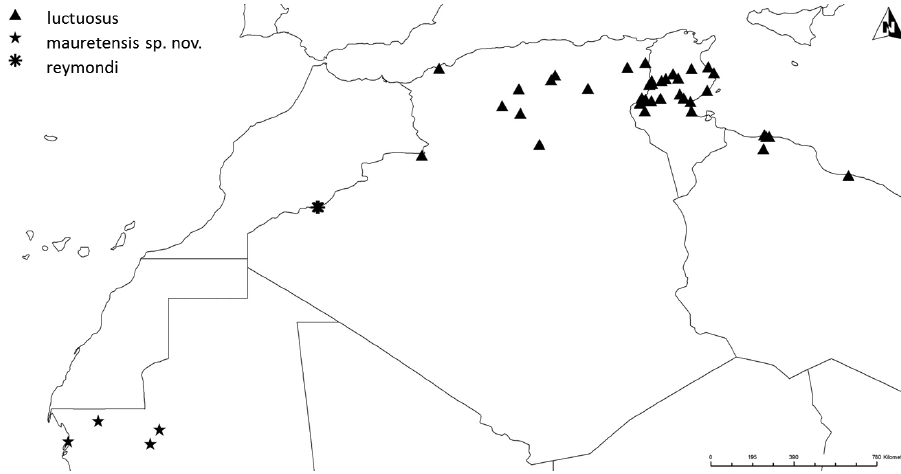
Figure 16. Distributional records of G. luctuosus , G. mauretensis sp. n., and G. reymondi